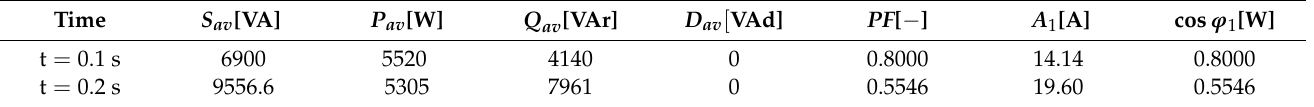
Table 2. Classical calculation before and after the change (at steady states).